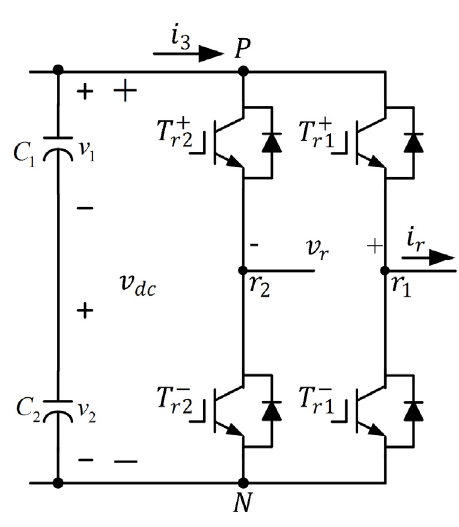
Figure 8. Power circuit of the three-phase, six-leg inverter (phase-r).